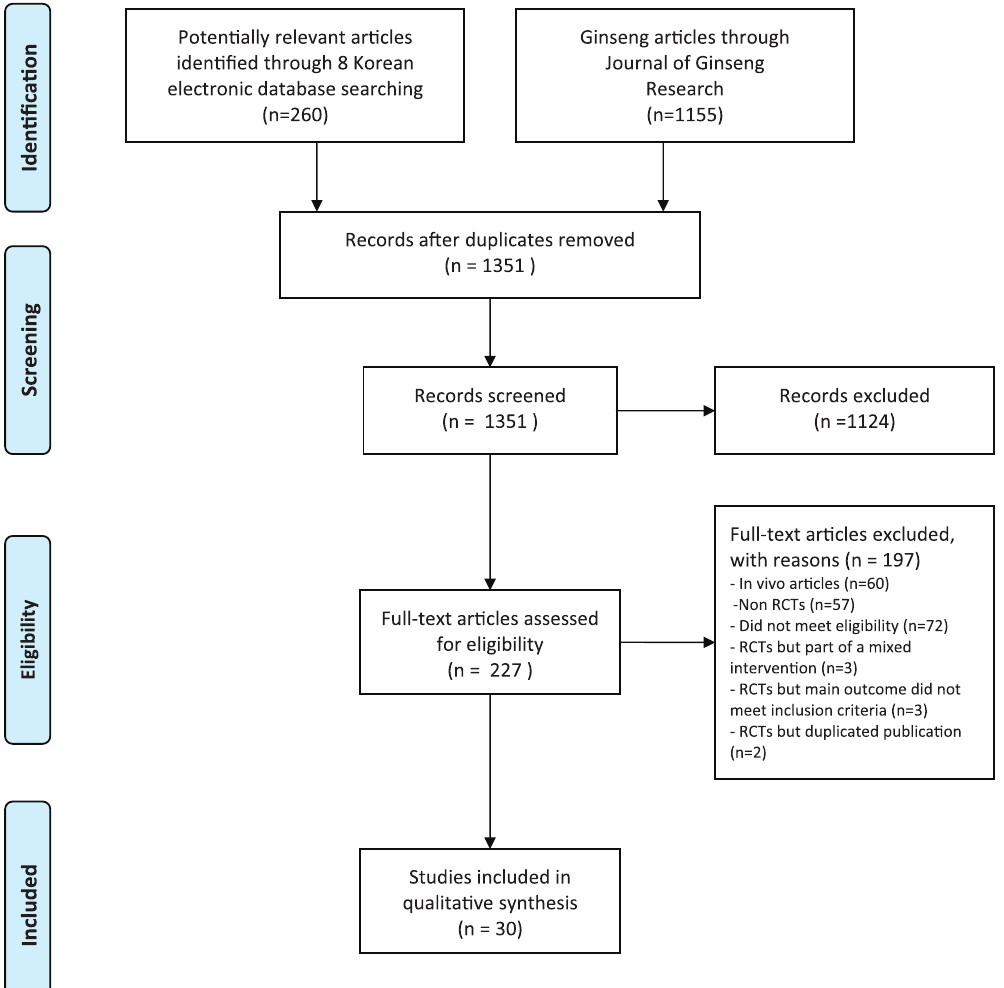
Figure 1. Flowchart of publication selection process. RCT: Randomized controlled trials.